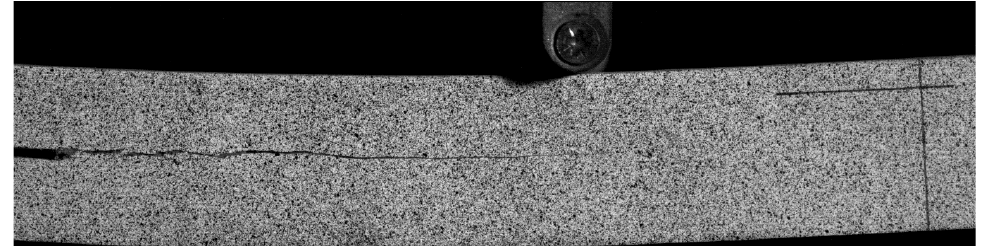
Figure 6. Example of the speckle image of the engineered bamboo crack.